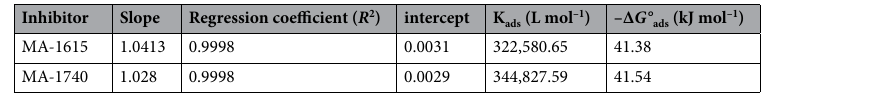
Table 6. Adsorption equilibrium constant ( K ads ) and standard free energy of adsorption (Δ G° ads ) of the investigated inhibitors for C-steel in 1 M HCl solution at 25 °C.